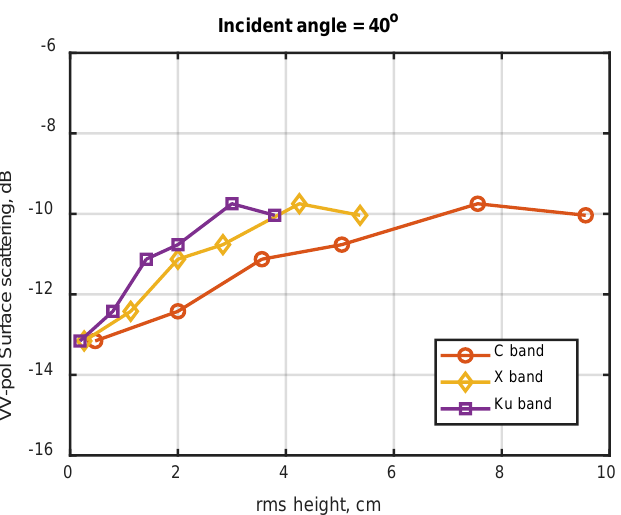
In Figure 20, we show the VV backscattering as a function of rms heights at C-, X-, and Ku-bands. The figures show saturation effects, meaning that rough-surface scattering saturates at large rms heights (~3–6 cm) and at high frequencies. The new results of kh up to 15 are useful for studying rough surface radar backscattering at the X- and Ku- bands for snow/soil interfaces.